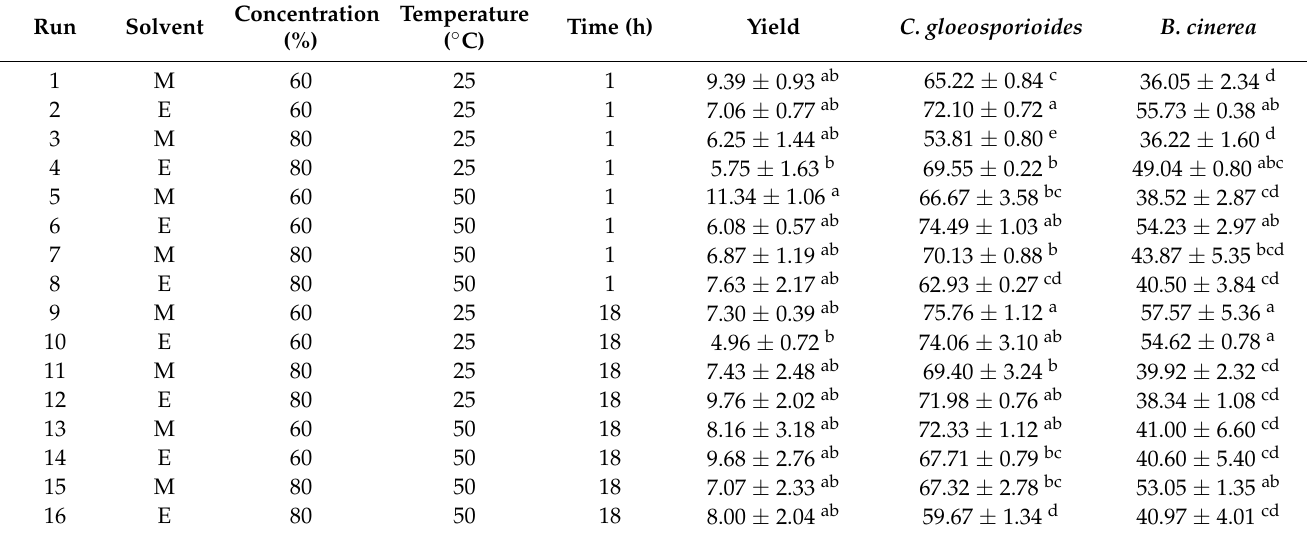
Table 4. Effect of extraction conditions on the yield and antifungal activity of garlic peel extracts †